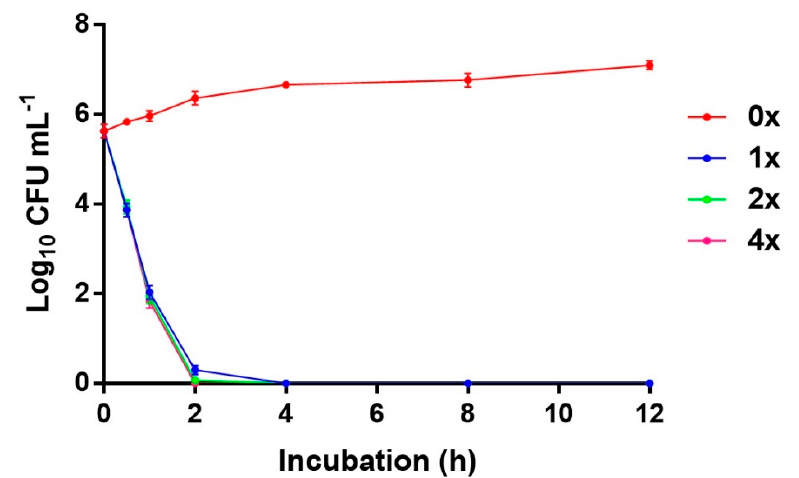
Figure 2. Effect of 2-Medpy-3-CN on the viability of methicillin-resistant Staphylococcus aureus (MRSA) grown in BHI at concentrations of 1 × , 2 × , and 4 × MIC with control (0 × MIC). MIC—minimum inhibitory concentration; CFU—colony-forming units.